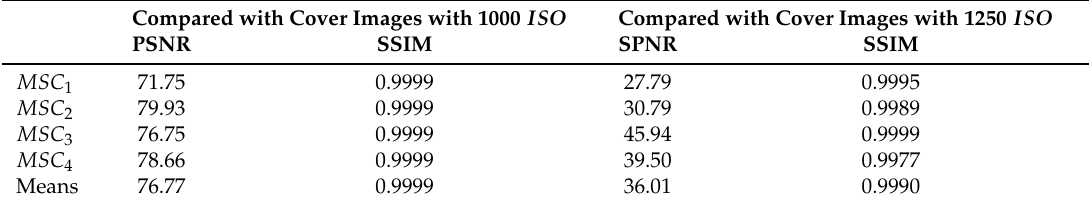
Table 1. The visual quality of the sharing images in Figure 5.